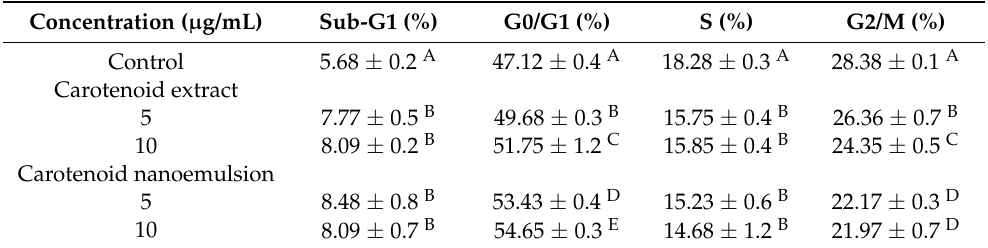
Table 4. Effect of carotenoid extracts and nanoemulsions on cell cycle distribution of human breast cancer cell MCF-7 1